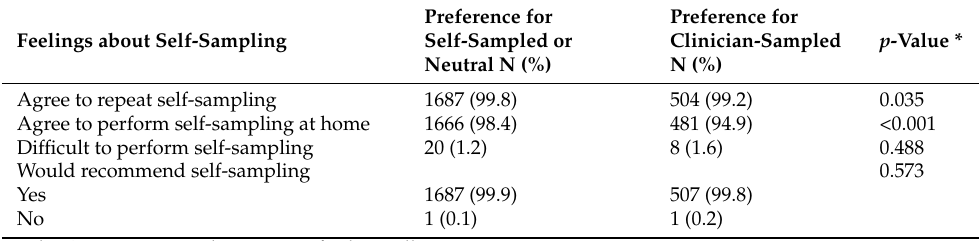
Table 2. Comparison of feelings about HPV self-sampling between preference